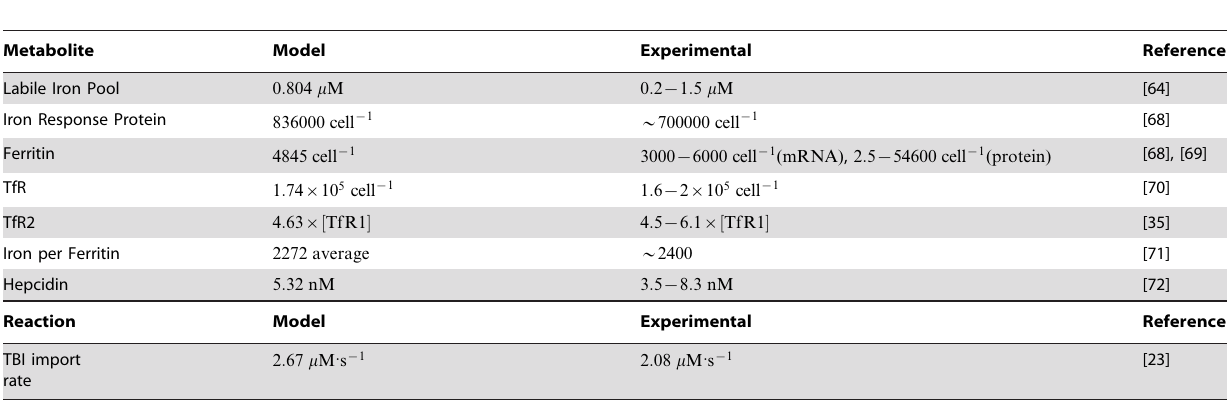
Table 3. Steady state validation—Comparison between model and experimental observations.